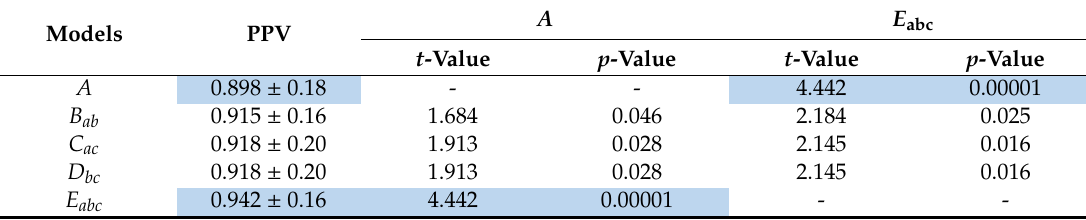
Table 3. Results for means of predictive probability value (PPV) and t -test evaluated using the distributions of PPV for the single ResNet (Model A ) and ensemble ResNets (Models B ab , C ac , D bc , and E abc ). The color background highlights the performance of the single ResNet model and the proposed ensemble